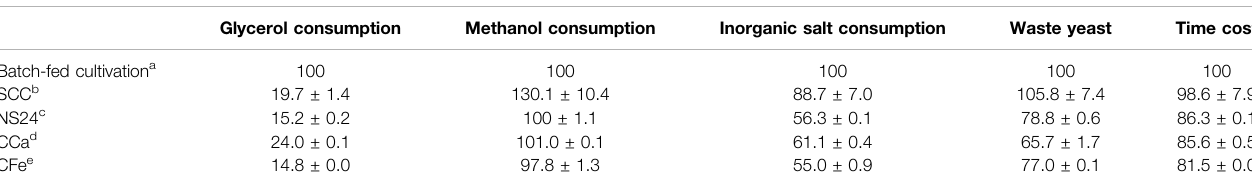
TABLE 1 | Assessment of G/Pel for three